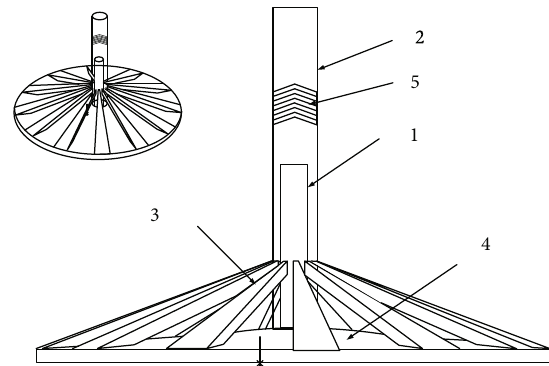
Figure 1: Schematic of the solar double-chimney humidi fi cation- dehumidi fi cation seawater desalination system (1 — inner chimney, 2 — outer chimney, 3 — sloped solar collector, 4 — horizontal solar collector, and 5 — condenser).